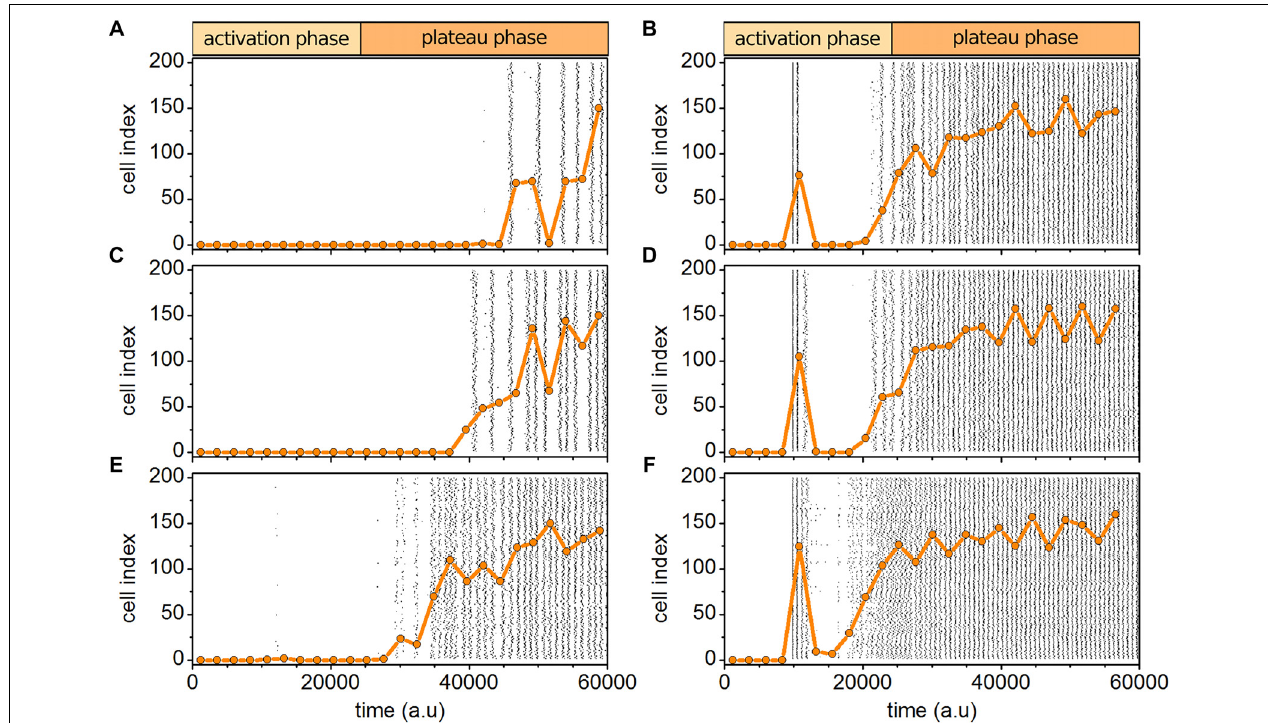
FIGURE 9 | Simulated beta cell responses for different degrees of heterogeneities. Simulating the behavior without (A,B) , with 10% (C,D) , and 20% (E,F) of the used degree of heterogeneities for physiological (A,C,E) and supraphysiological (B,D,F) stimulation